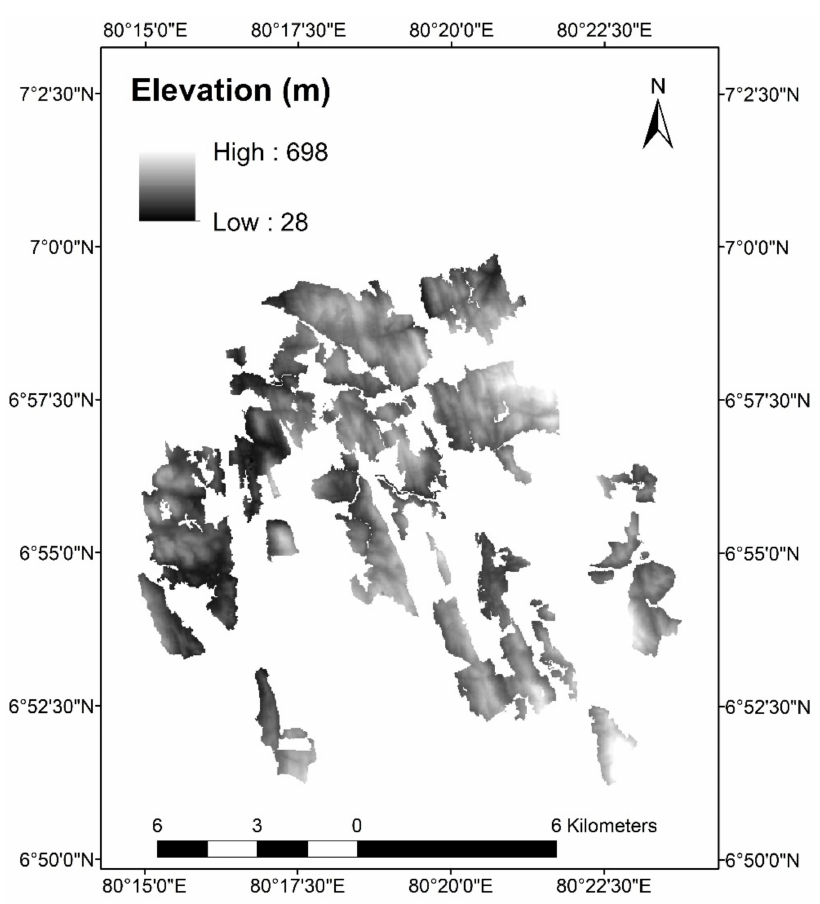
Figure 3. Generated DEM of the study